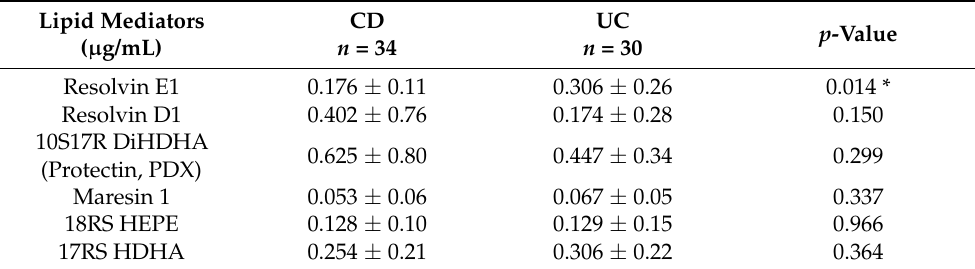
Table 1. Characteristics of lipid mediators between CD and UC (total). Lipid Mediators ( μ g/mL)